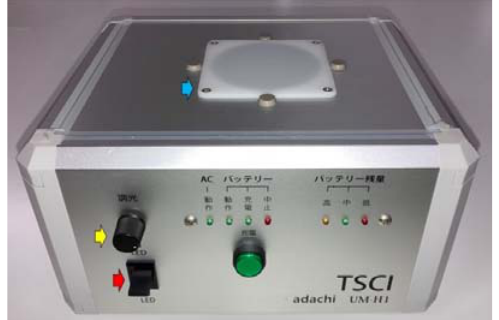
Figure 1. Main unit of TSCI. On the front of the device, there is a tab to switch the 605 nm wavelength light (red arrow), a knob to adjust the light intensity (yellow arrow), and a lamp to check the operation status. In the center of the upper surface of the device, there is a white plate that emits transmitted light from below, and a Petri dish containing the specimen is placed on this plate (blue arrow). Abbreviation: TSCI, target sample check